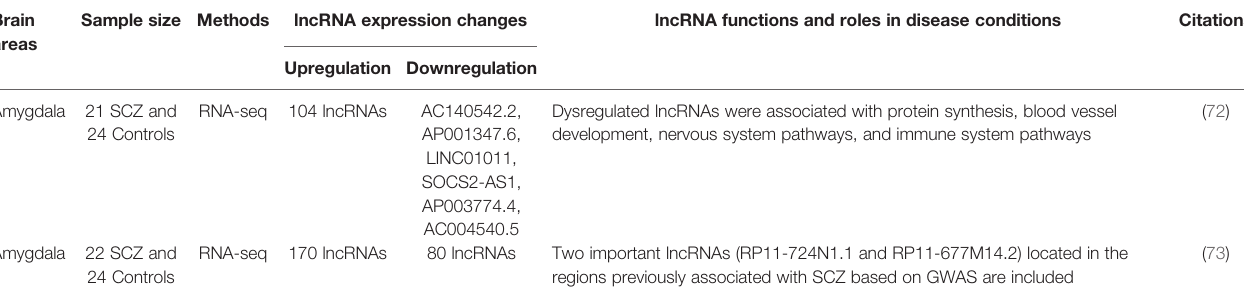
TABLE 1 | LncRNA expression changes in psychiatric disorders based on postmortem brain studies.